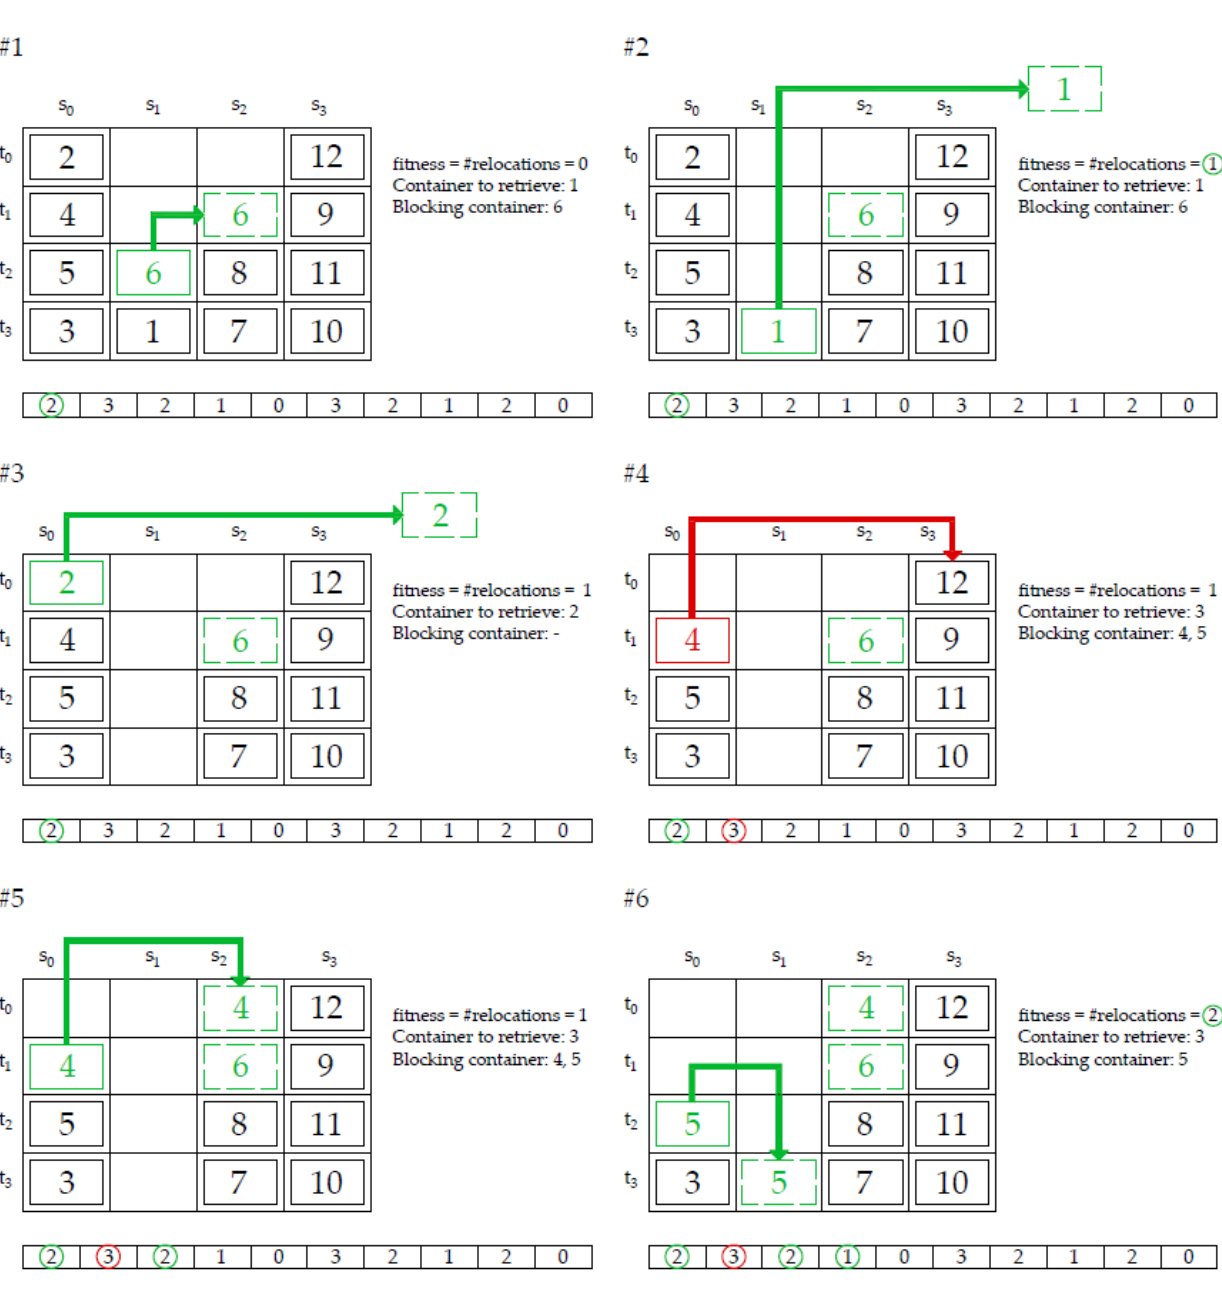
Figure 7. A complete fitness function calculation (1).